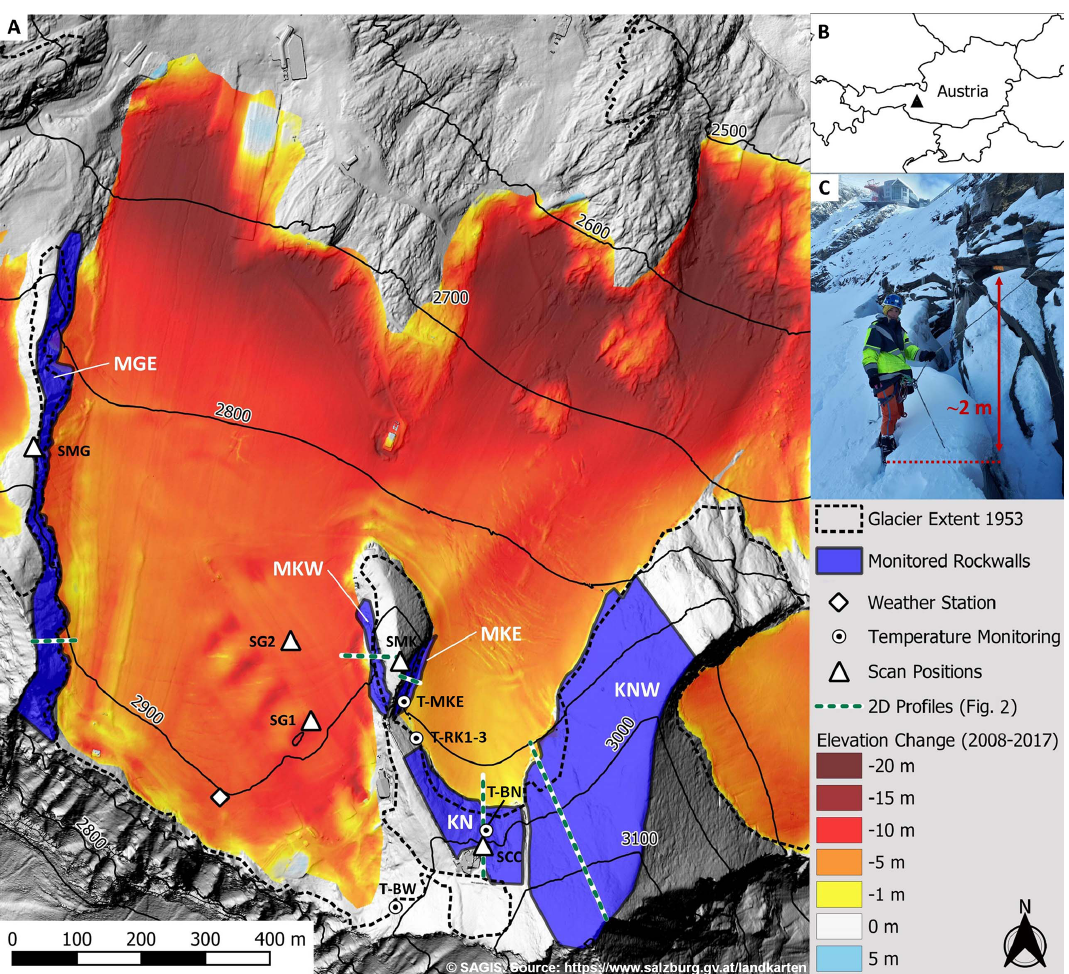
Figure 1. (a) Hillshade of study area with monitored rockwalls, scan positions, 1953 glacier extent and elevation changes of the surface of the Schmiedingerkees between 2008 and 2017. While glacial thinning is most evident near the terminus, pronounced ice surface lower- ing ( ∼ 0.7ma − 1 ) is also observed adjacent to the monitored cirque walls. (b) Location of study site within Austria (47.19 ◦ N, 12.68 ◦ E). (c) Glacier surface lowering 2015–2019. Orange spray marker on rockwall indicates glacier surface level on 4 September 2015 (photo: Ingo Hartmeyer, 9 September 2019). Abbreviations: KN is the Kitzsteinhorn north face, KNW is the Kitzsteinhorn northwest face, MKE is the Magnetkoepfl east face, MKW is the Magnetkoepfl west face, MGE is the Maurergrat east face, SMK is the scan position “Mag- netkoepfl”, SCC is the scan position “Cable Car Top Station”, SG1 is the scan position “Glacier 1”, SG2 is the scan position “Glacier 2”, SMG is the scan position “Maurergrat”, T-BN is the deep borehole (30m) at the Kitzsteinhorn north face, T-BW is the deep borehole (30m) at the Kitzsteinhorn west face, T-MKE is the shallow borehole (0.8m) at the Magnetkoepfl east face, and T-RK1-3 is the shallow boreholes (0.8m) inside the